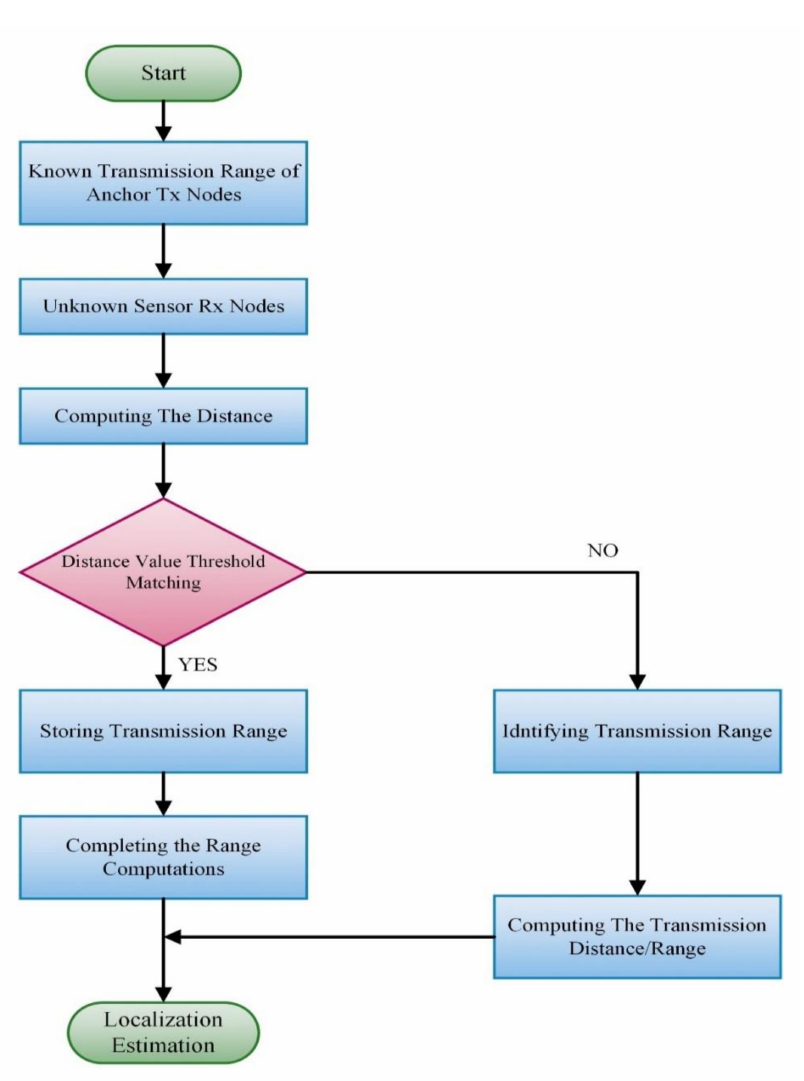
Figure 7. Flow chart describing the algorithm used for localization estimation of sensor Rx